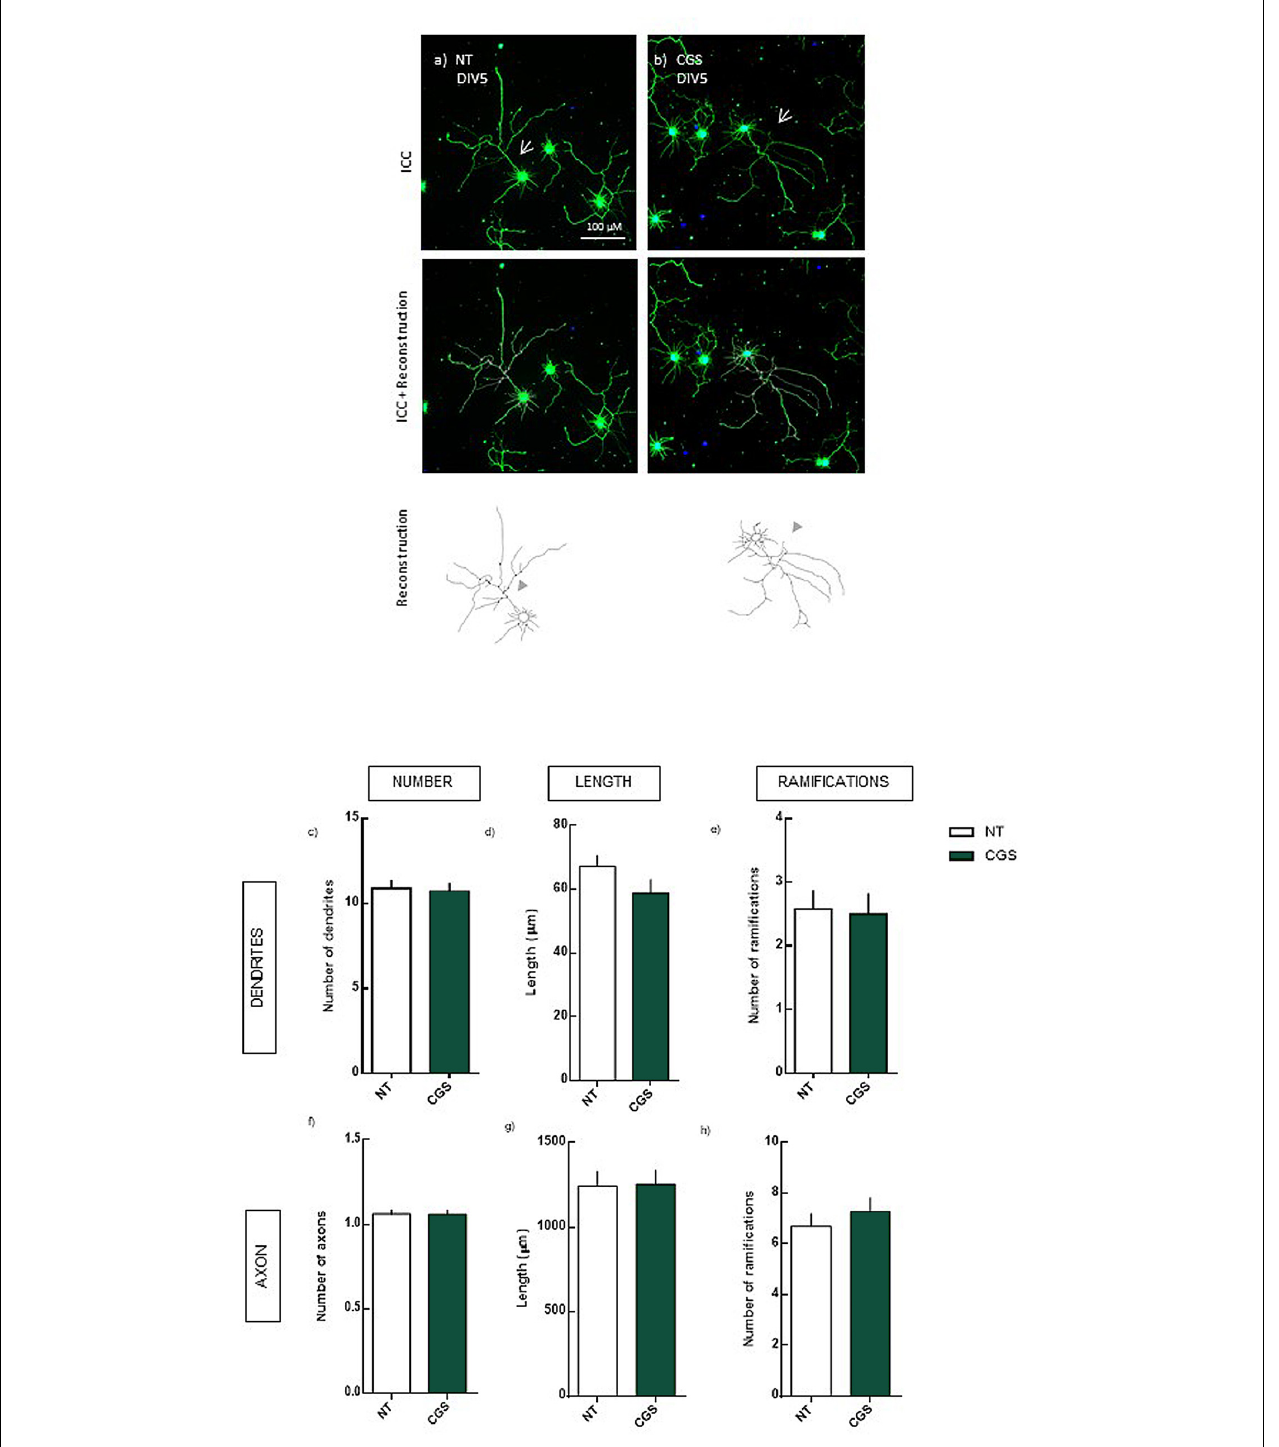
FIGURE 3 | Effect of the selective activation of A 2A R (4 days treatment) in hippocampal neurons (DIV5). Hippocampal neurons from ED18 rats were cultured in vitro for 5 days (DIV5). Cultured neurons were treated with the A 2A R agonist, CGS (30 nM), at 24 h in culture. Neuronal morphology was assessed by manual reconstruction in Neurolucida software (a,b) and morphometric data were acquired in Neurolucida Explorer, regarding the number (c) , length (d) , and number of ramifications (e) of dendrites and the number (f) , length (g) , and number of ramifications (h) of axons (identified with an arrow in the representative images). Results are expressed as mean ± SEM of 97–100 cells, from four independent experiments. No statistical significance comparing NT with CGS treatment, assessed by t -student test. ICC, immunocytochemistry; NT, non-treated; CGS, CGS21680, A 2A R agonist.